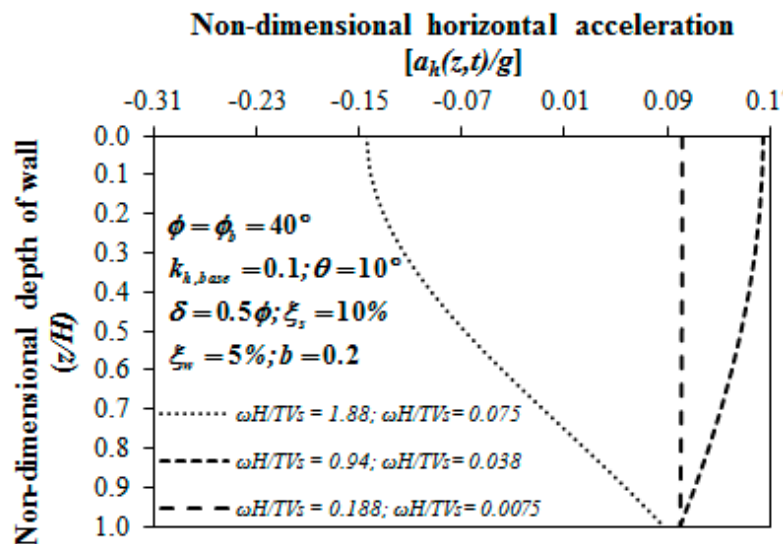
Figure 3. Distribution of non-dimensional horizontal acceleration versus non-dimensional depth of the wall at the instance of maximum value of F W .